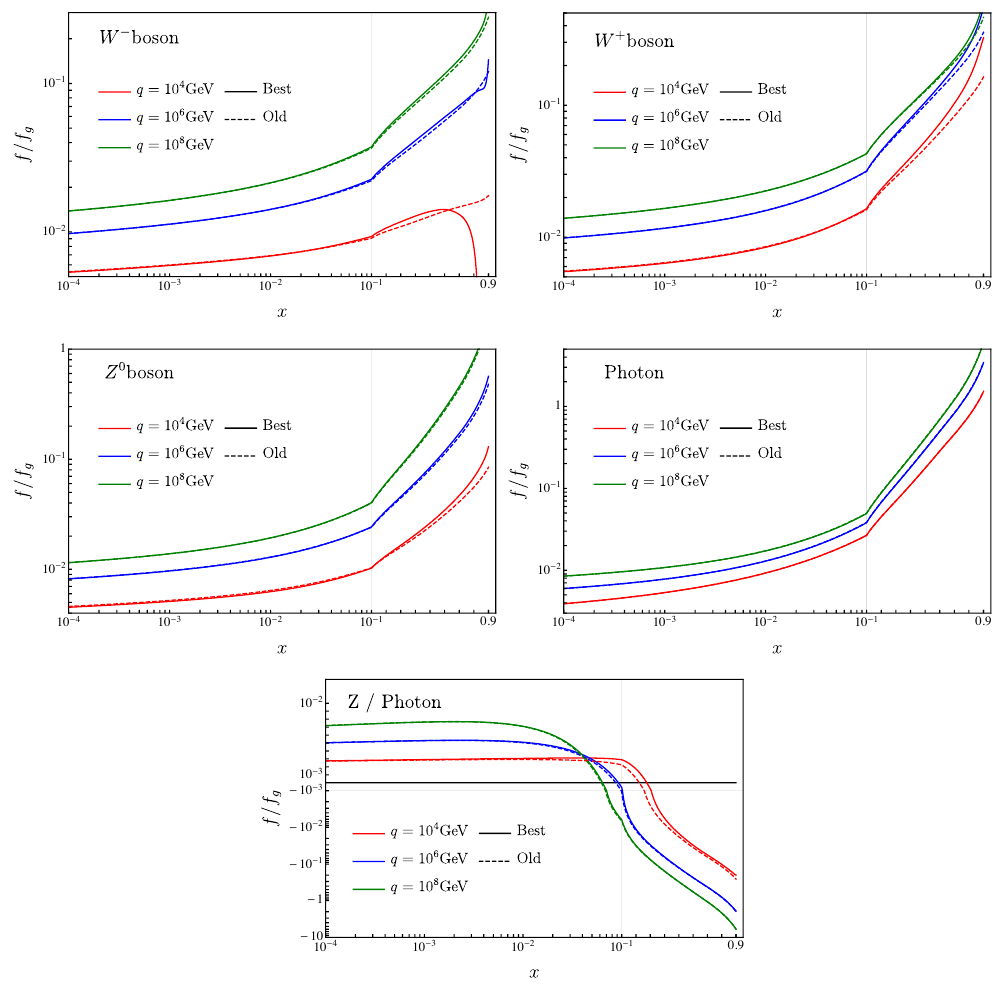
Figure 4 . Unpolarized transverse electroweak boson PDFs normalized by the gluon PDF. The thin gray lines show where the scales on the x- and/or y-axes switch between linear and